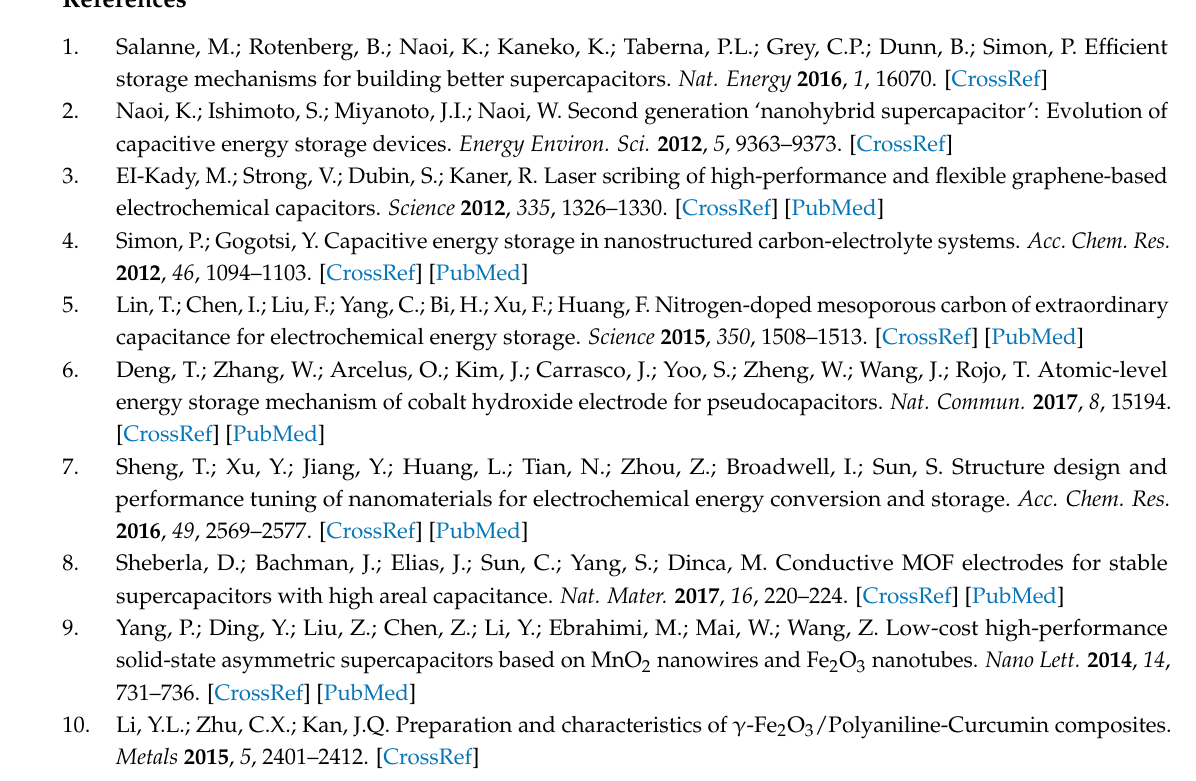
Figure 5, the R s values for the Fe 2 O 3 @CC electrode in LiNO 3 and LiTFSI + LiBETI solution are 2.32 and 3.72 Ω , respectively, which are approximatelyequal. The R ct values in LiNO 3 and LiTFSI + LiBETI solution are 287.12 and 379.28 Ω , respectively. The higher charge transfer resistance may be